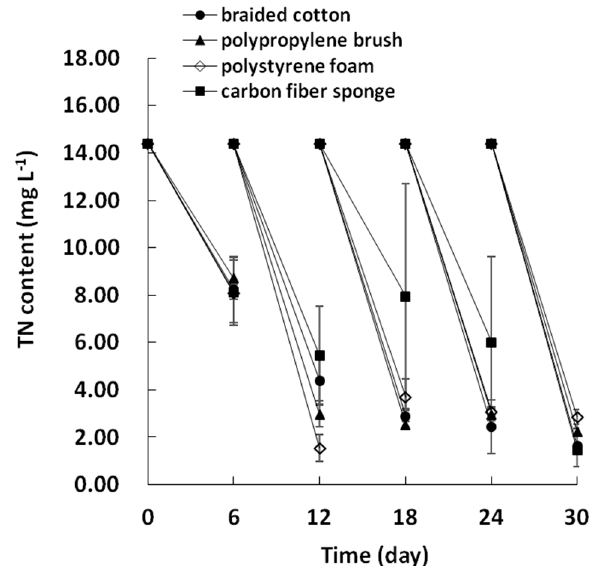
Figure 3. Total nitrogen concentration in the bioremediation test with different biofilm carriers (Error bars represent the standard deviation, N = 2).